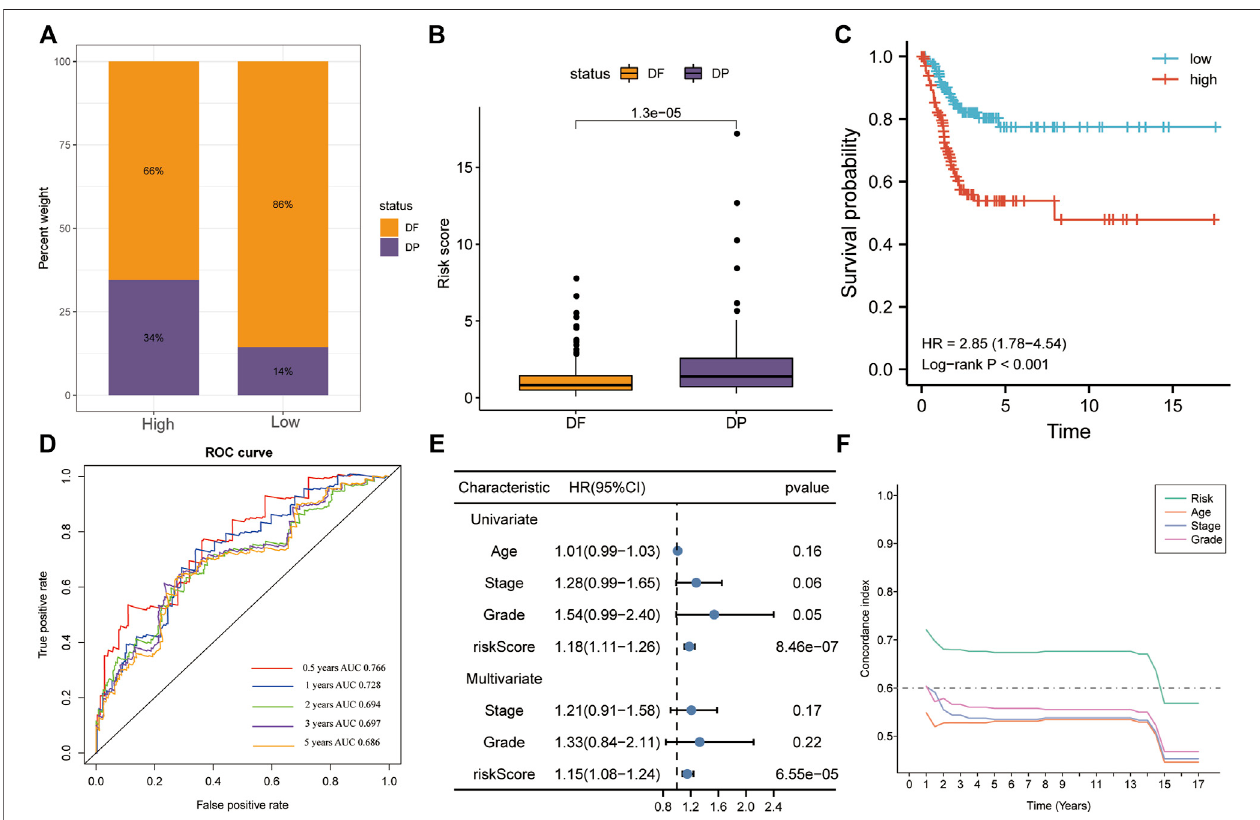
FIGURE5| Theriskscorewasthe onlysigni fi cantindependent riskfactor predicting PFSinthetrainingset. (A) Thehigh-risk groupcontainedagreater proportion ofpatientswithdiseaseprogression. (B) Patientswithdiseaseprogressionhadsigni fi cantlyhigherriskscores. (C) Patientswithhighriskscoreshadapoorerprognosis, according to KM analysis. (D) The risk score was a good predictor of PFS (AUC > 0.68). (E) Univariate and multivariate Cox regression for PFS revealed that risk score was the only signi fi cant independent risk factor among included clinicopathological variables. (F) The C-index indicated that the risk score had the best PFS predictive ability. PFS, progression-free survival; AUC, area under the ROC